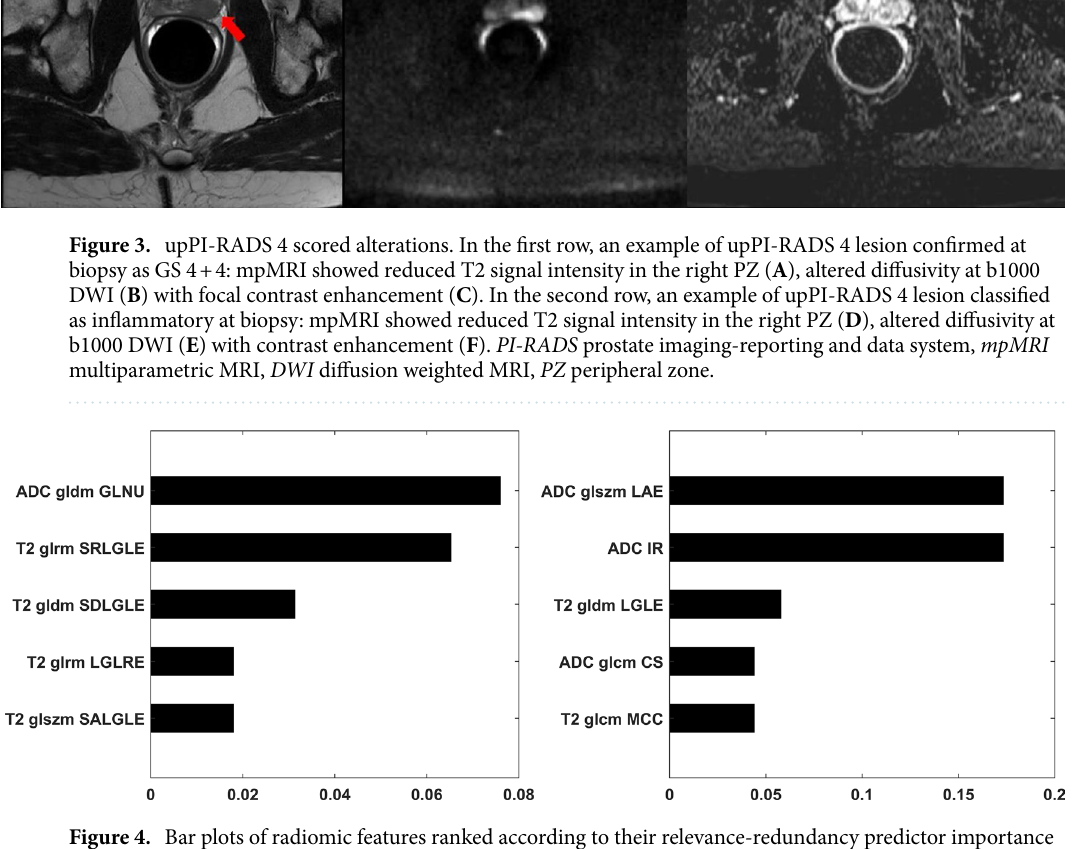
Figure 4. Bar plots of radiomic features ranked according to their relevance-redundancy predictor importance score for PI-RADS 3 (left side) upPI-RADS4 (right side) lesion detection tasks. ADC apparent diffusion coefficient, glcm gray level co-occurrence matrix, glrlm grey level run length matrix, gldm gray level dependence matrix, glszm grey level size zone matrix, SDLGLE Small Dependence Low Gray Level Emphasis, SALGLE Small Area Low Gray Level Emphasis; SRLGLE Short Run Low Gray Level Emphasis; LAE Large Area Emphasis; IR Interquartile Range; LGLE Low Gray Level Emphasis; CS Cluster Shade; MCC Maximal Correlation